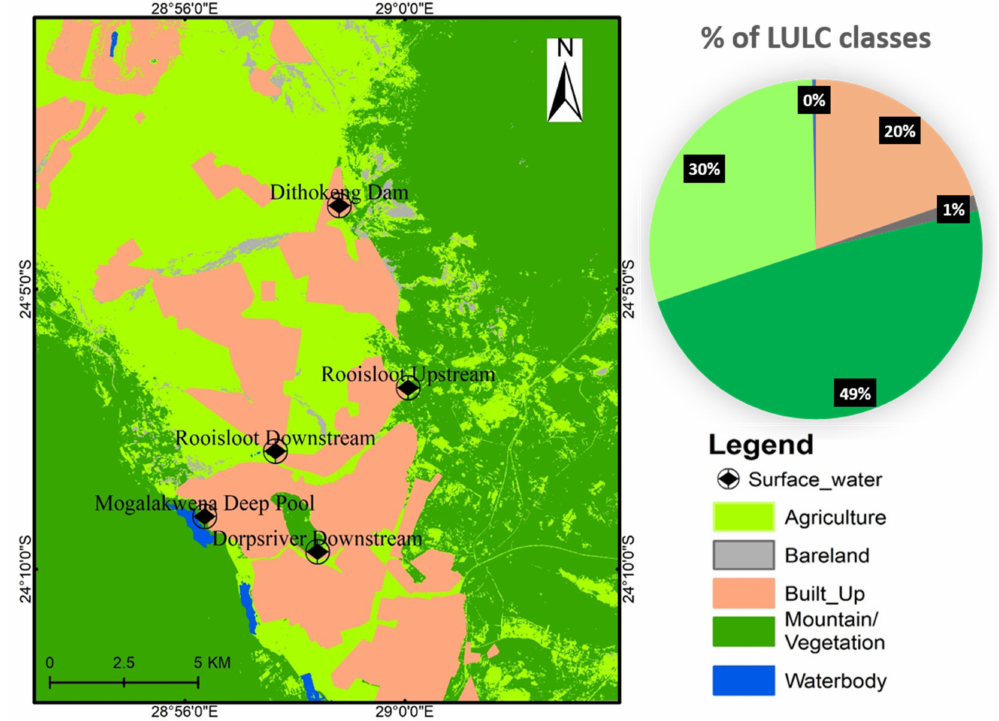
Figure 3. Land use/land cover (LULC) map of the study area and pie chart shows percentage of various